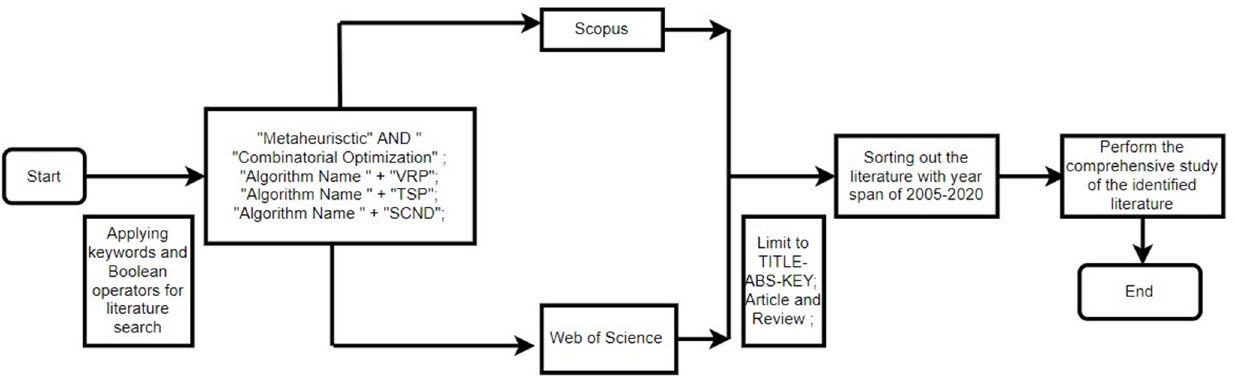
Figure 3. Systematic literature